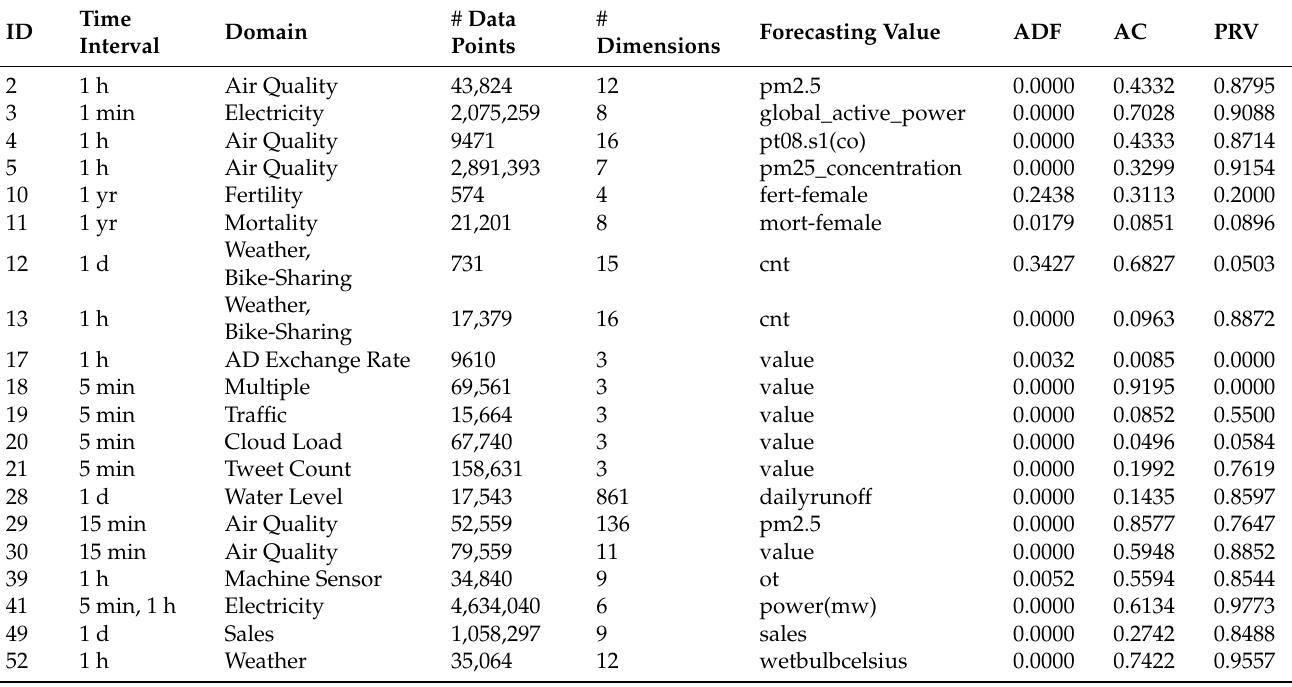
Table 6. Overview of statistical features of public dataset time series forecasting